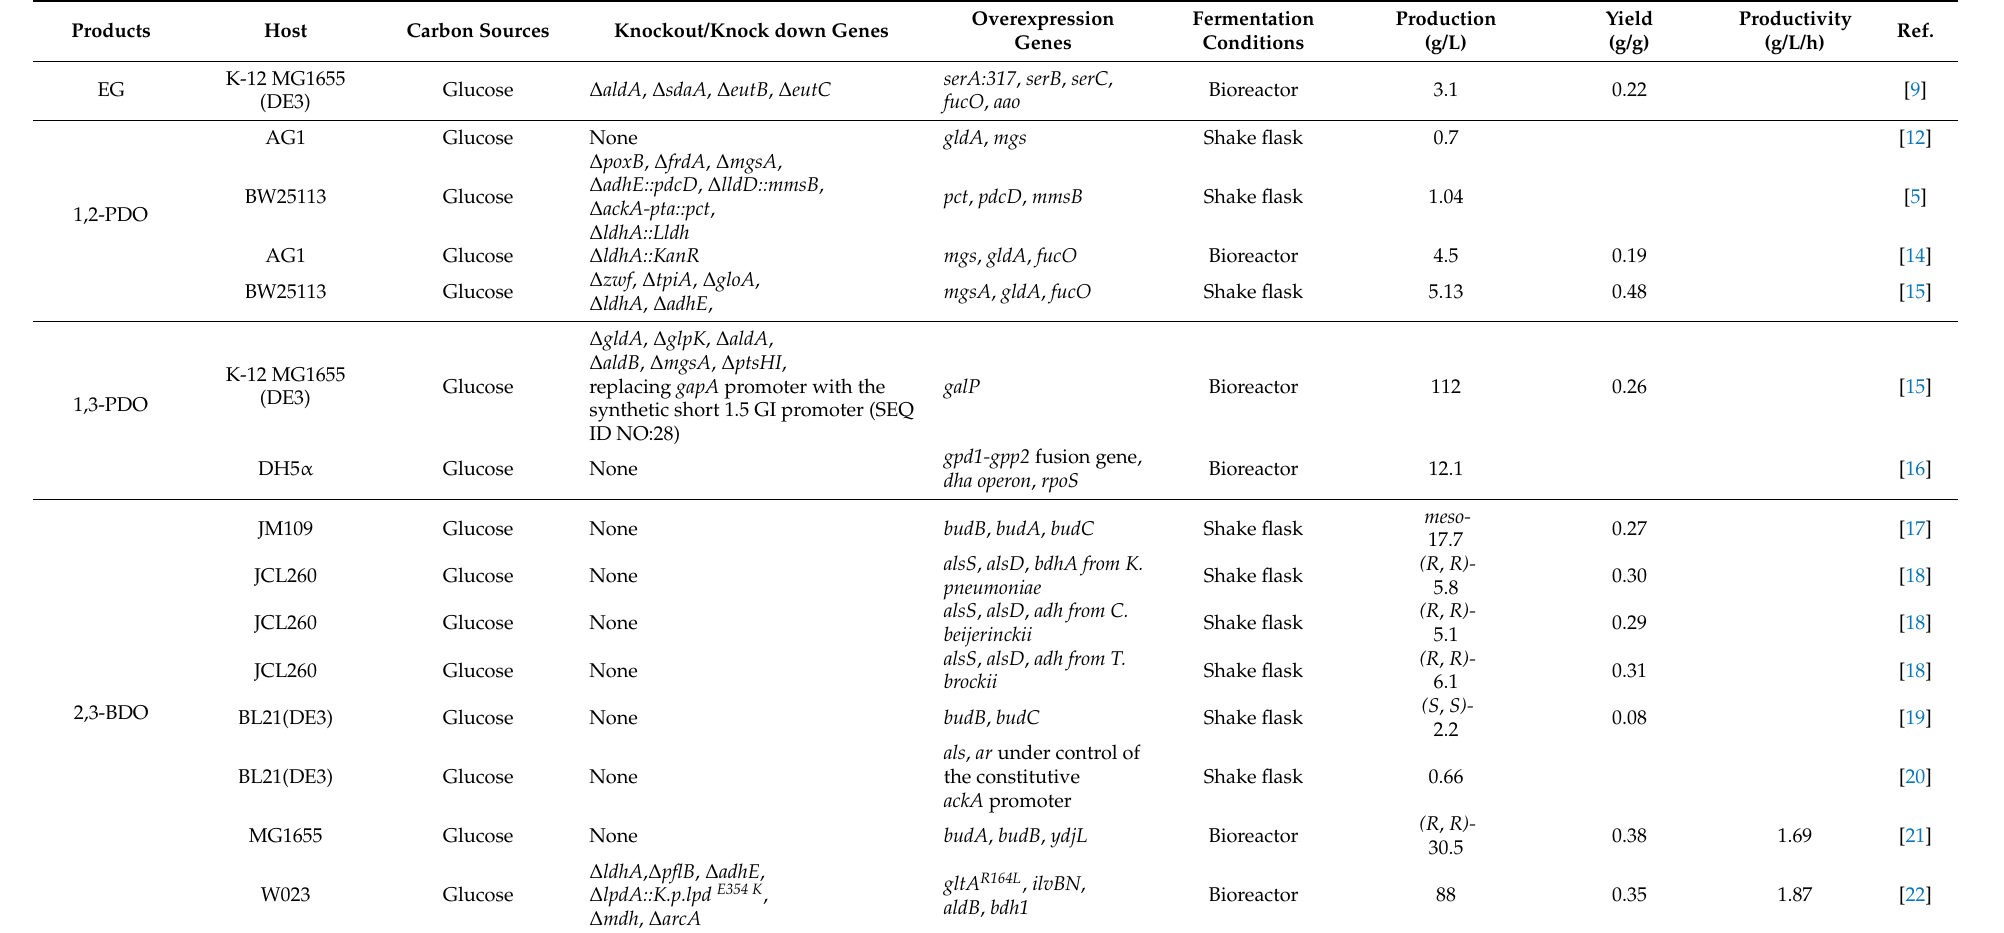
Table 1. Summary of diols production from glucose in E. coli